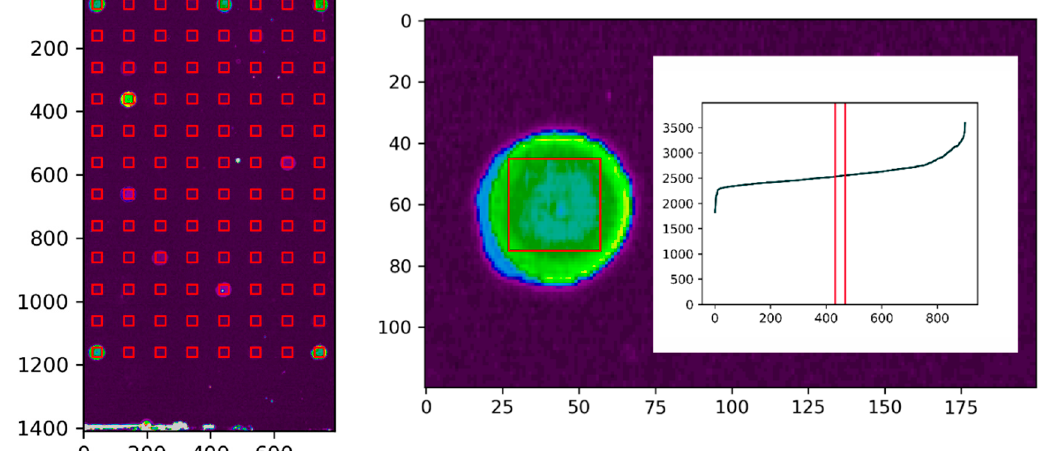
Figure 7. Scan of the microarray ( left ) with generated square regions of interest (ROI) over all spots of the array for the semi-automatized data evaluation with the Python script. ROI of the first spot ( right ) with included pixels, which were sorted according to their intensity. In total, 2% of the central pixels were used for the evaluation.